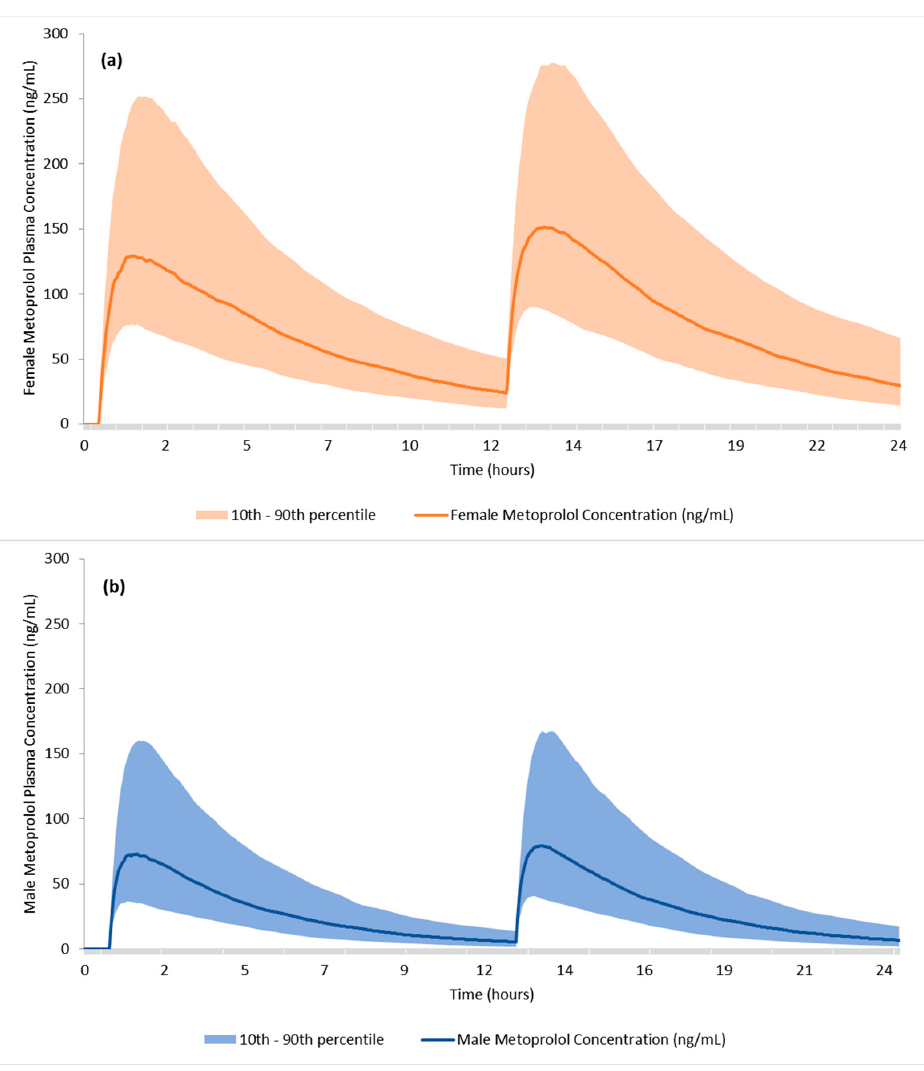
Figure 3. Dose ‐ finding simulation results of two 100 mg doses of metoprolol every 12 h, for ( a ) men and ( b ) women. The results are based on the S ‐ metoprolol modeling parameters where the solid lines illustrate the typical value of plasma concentrations and the shaded bands represent the 10th and 90th percent confidence interval for 3000 virtual patients. Table 2. Gender-stratified population pharmacokinetic model estimates from the Clinical Trial Simulation